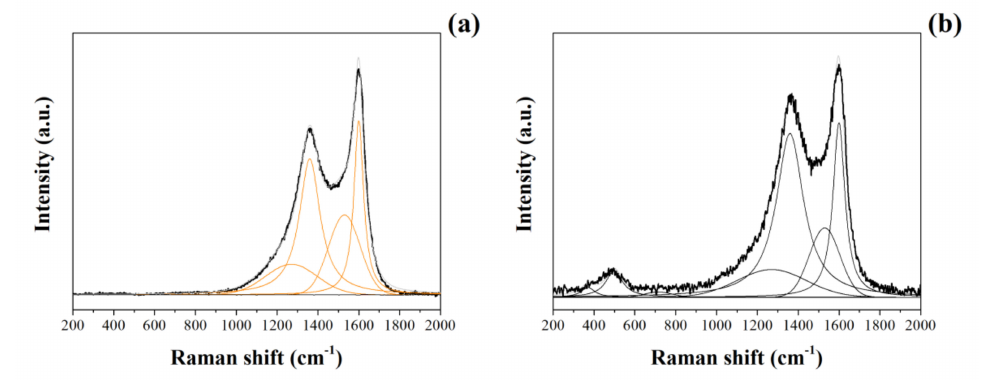
Figure 2. Raman spectra of CNFs ( a ) and NiO@CNFs ( b ) obtained at 488 nm. A comparison of the XPS findings obtained for the two different samples was per- formed. In this sense, Figure 3 shows the long-range XPS spectra (Figure 3a,d), as well as the short-range spectra for the different chemical species: C1s (Figure 3b,e), O1s (Figure 3c,f), and Ni2p (Figure